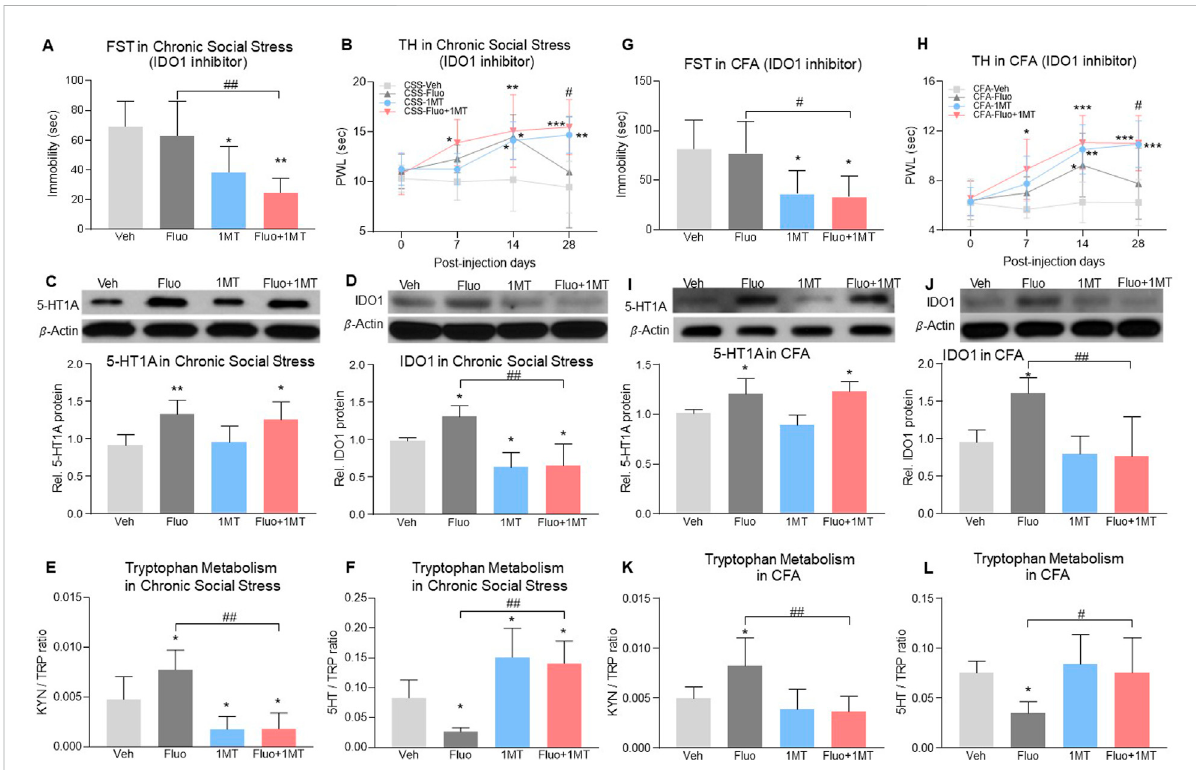
FIGURE 6 Inhibition of IDO1 activity maintained fl uoxetine ’ s antidepressant and antihyperalgesic effect. (A) In the chronic social stress model, treatment with 1MT alone or in combination with fl uoxetine decreased the immobility time in FST on day 28 as compared to vehicle-treated rats. (B) PWL was increased by fl uoxetine or 1MT alone from day 14 but fell back to baseline on day 28 in fl uoxetine alone group (CSS-Veh vs. CSS-Fluo or CSS-1MT). Combinedwith1MT, fl uoxetineincreasedPWLfromday7(CSS-Vehvs.CSS-Fluo+1MT)andmaintaineditsantihyperalgesticeffectsuptoday28 (CSS-Fluo vs. CSS-Fluo+1MT) (C,D) Expression of 5-HT1A receptors and IDO1 in the DRN was increased by fl uoxetine maintenance treatment in chronic social stress rats as compared to vehicle-treated rats (CSS-Veh vs. CSS-Fluo). 1MT alone (CSS-Veh vs. CSS-1MT) or in combination with fl uoxetine (CSS-Veh vs. CSS-Fluo+1MT, CSS-Fluo vs. CSS-Fluo+1MT) decreased the protein level of IDO1 (D) but 5-HT1A receptors (C) . (E,F) 1MT alone or in combination with fl uoxetine reduced the IDO activity in the DRN, which was elevated by fl uoxetine alone. (G,H) In the CFA model, 1MT maintained antidepressant and antihyperalgestic effects of fl uoxetine up to day 28 (CFA-Fluo vs. CFA-Fluo+1MT). 1MT combined with fl uoxetine or alone treatment increased PWLfrom day 7 and day 14 respectively as compared to vehicle-treated CFA rats. Fluoxetine alone increased PWL on day 14only(CFA-Vehvs.CFA-Fluo). (I – L) 1MTdecreasedexpressionandactivityofIDO1(CFA-Fluovs.CFA-Fluo+1MT),whichprevented fl uoxetinefrom increasing expression and activity of IDO1 (CFA-Veh vs. CFA-Fluo). The data are presented as mean ± SD ( n = 6). * p < 0.05, ** p < 0.01 and *** p